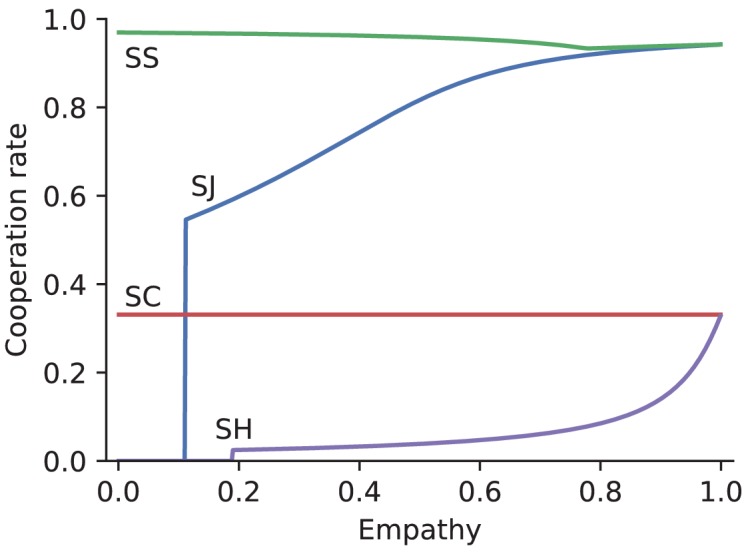
Cooperation rates at the cooperative equilibria of strategy evolution.For Stern Judging (SJ) and Shunning (SH) norms the cooperative equilibrium (when it exists) corresponds to a homogeneous population of DISC players, while for Simple Standing (SS) and Scoring (SC) it consists of a mixture of ALLC and DISC strategists. b/c=5, e1=e2=0.02.